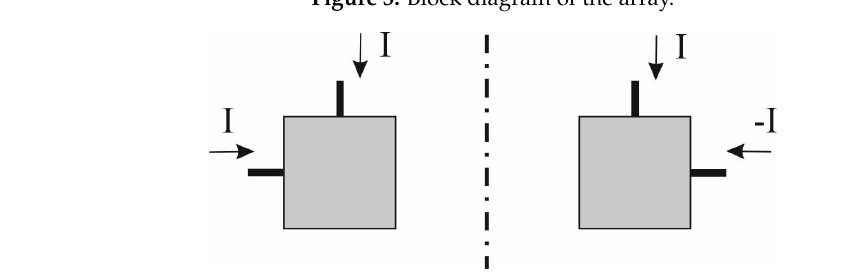
Figure 3. Block diagram of the array.